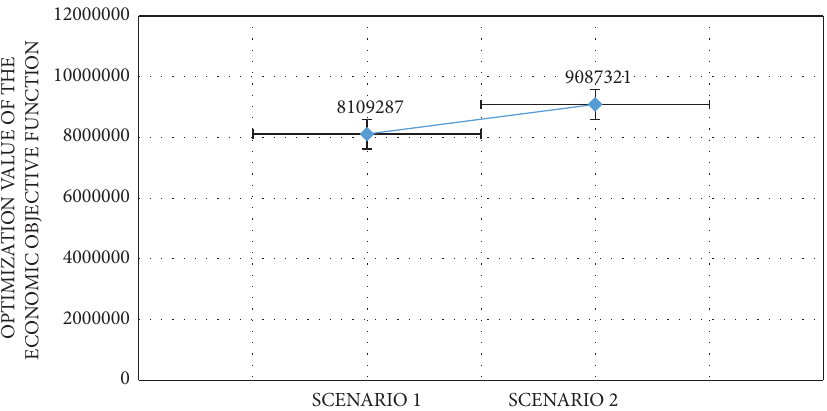
Figure 12: Sensitivity analysis of social aspect (normal COVID)